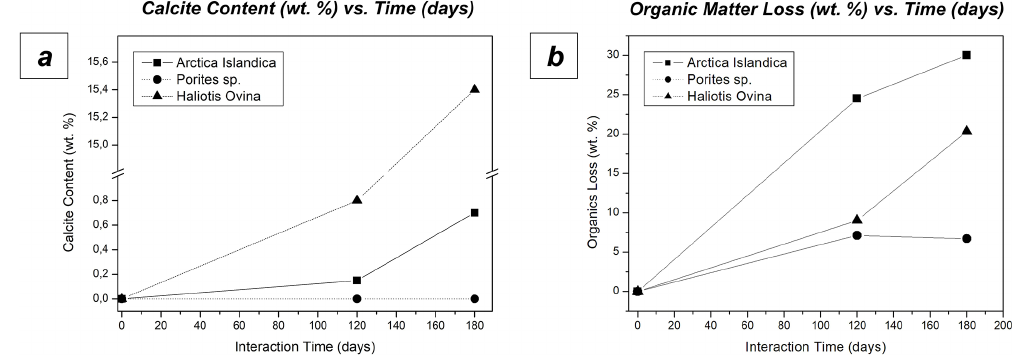
Figure 8. (a) Calcite content obtained from Rietveld analysis derived from XRD data and (b) organic matter loss measured with TGA with increasing alteration time. The influence of the individual aragonitic microstructure on both parameters is remarkable. Table 1. Change in aragonite grain area/grain size with increasing hydrothermal alteration for inner and outer layers of Arctica islandica . The drastic decrease in the number of smaller grains and the concomitant increase in the number of larger grains are